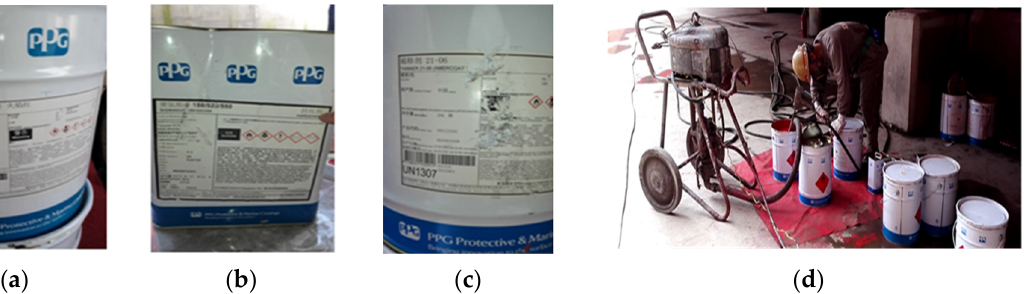
Figure 12. Shipyard experimental paint and operation: ( a ) Topcoat base (SIGMADUR 550 BASE RAL 3000); ( b ) Hardener (SIGMADUR) 188/520/550; and ( c ) Thinner21-06 (AMERCOAT). ( d ) The worker is mixing three paints in proportion.